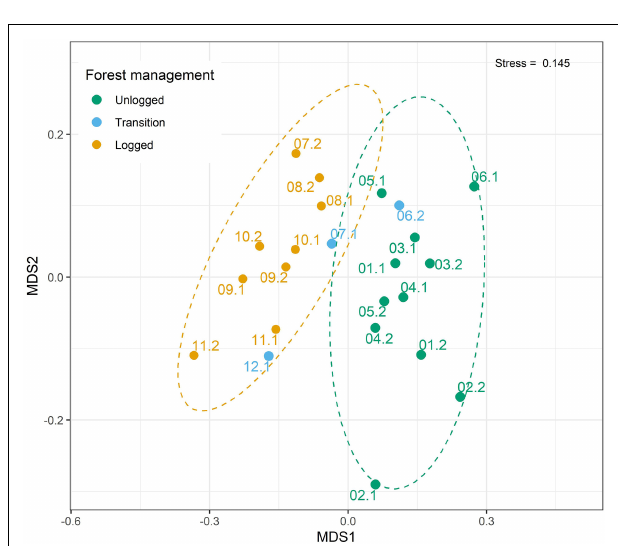
FIGURE 3 | Non-metric multidimensional scaling (NMDS) for bird species (quantitative data) in three groups of unlogged, transition and logged areas collected in 160 point counts of 23 half-trails of the management area at Fazenda Pau D’Arco, Crato, Ceará, Brazil. Color dots indicate unlogged (dark green), transition (blue), and logged (yellow)